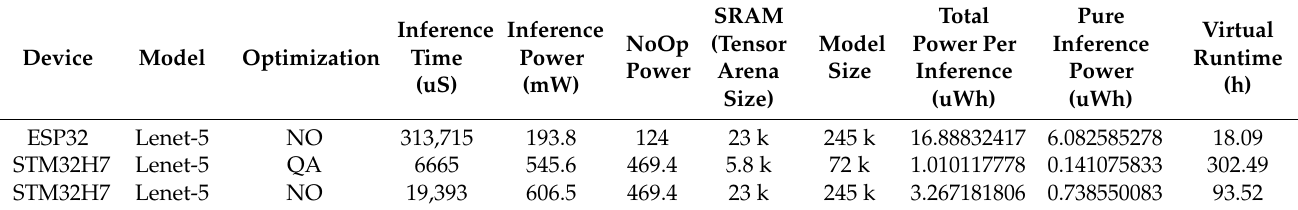
Table 1. Lenet-5 Table 1. Lenet-5 Results.